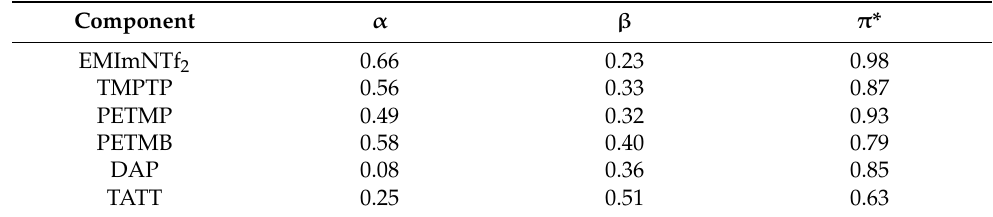
Table 2. Kamlet–Taft parameters of tested thiol and ene monomers and ionic liquid EMImNTf 2 .